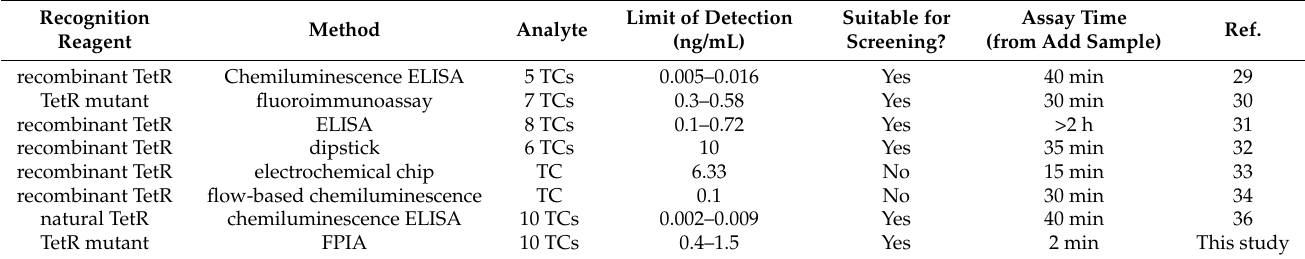
Table 3. Comparisons with the previous TetR-based methods for TCs.